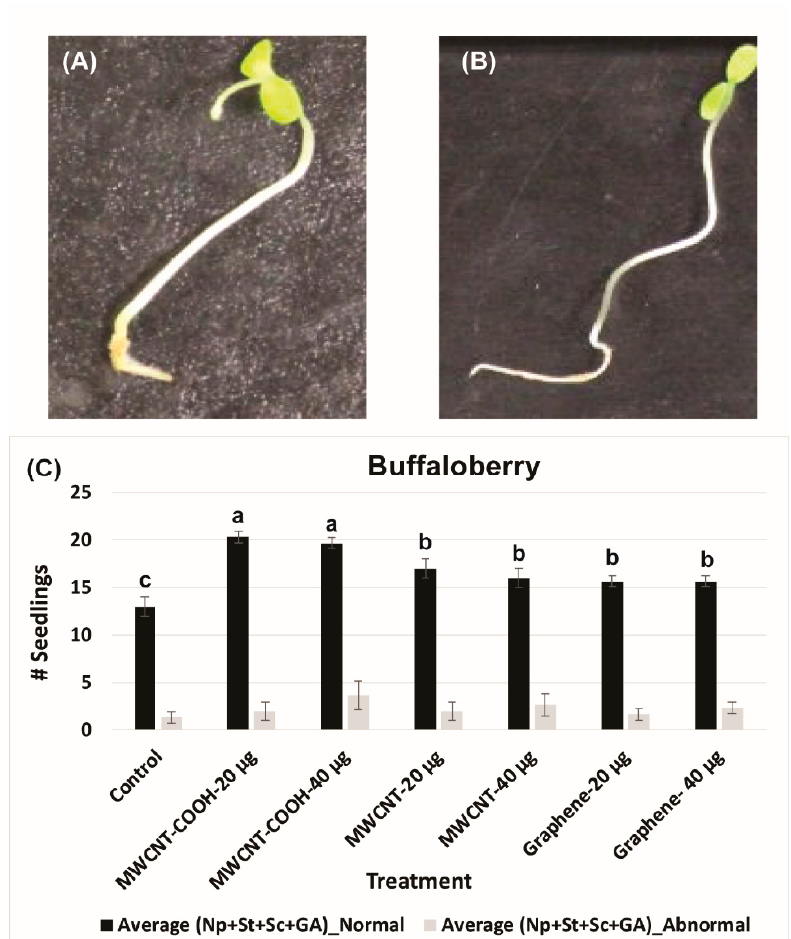
Figure 3. Abnormal ( A ) and normal ( B ) buffaloberry seedlings observed during current study. Effect of different treatments on total number of normal and abnormal seedlings in buffaloberry ( C ). Each bar presents total number of seedlings ± standard errors, whereas bars sharing different letters are significant different from each other at α = 0.05. Control = no CNPs added, MWCNT–COOH = multiwall carbon nanotubes functionalized with carboxylic acid, MWCNT= multiwall carbon nanotubes, UP-con NP = up conversion nanophosphors, N = 100 plants per treatment.